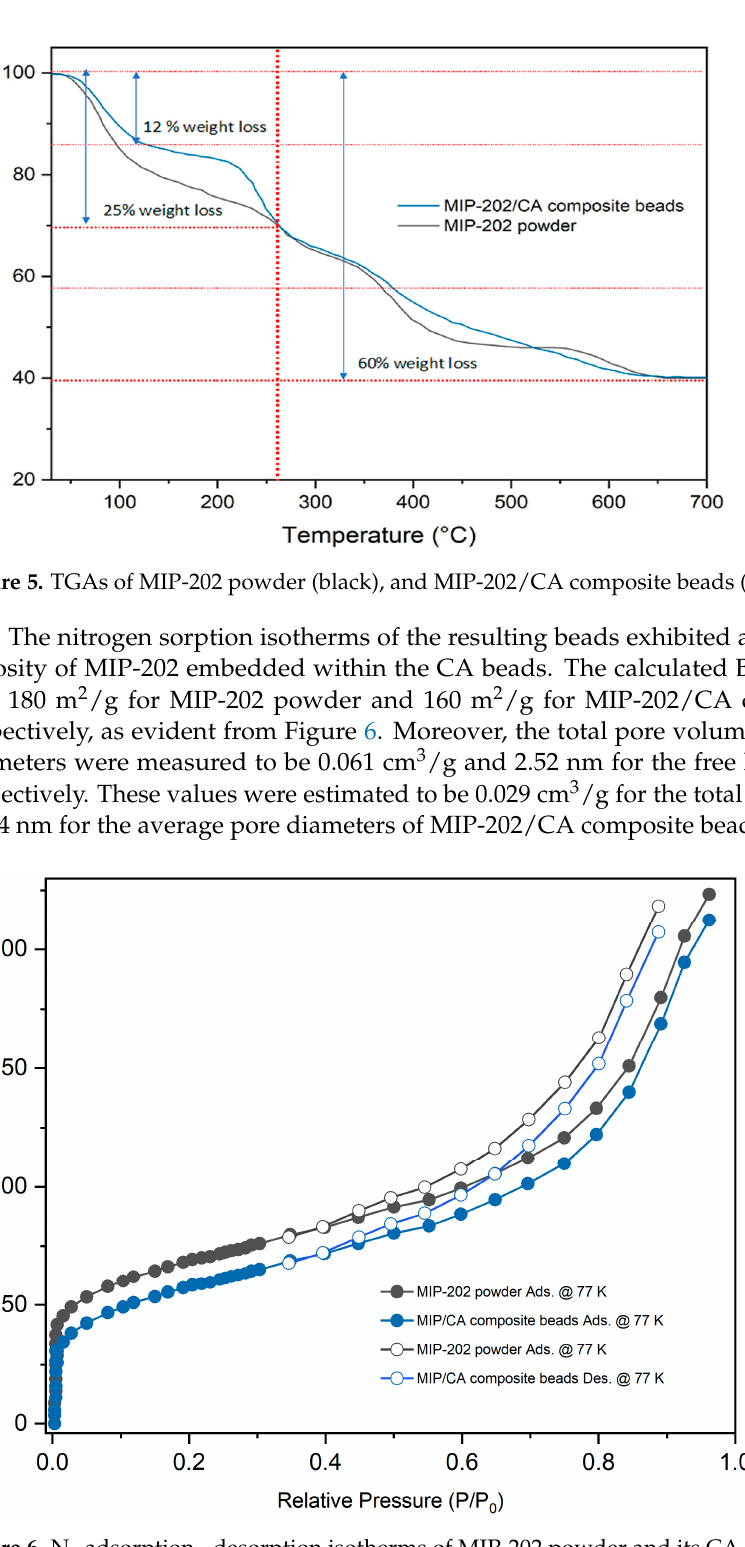
Figure 6. N 2 adsorption − desorption isotherms of MIP-202 powder and its CA polymeric composite beads.